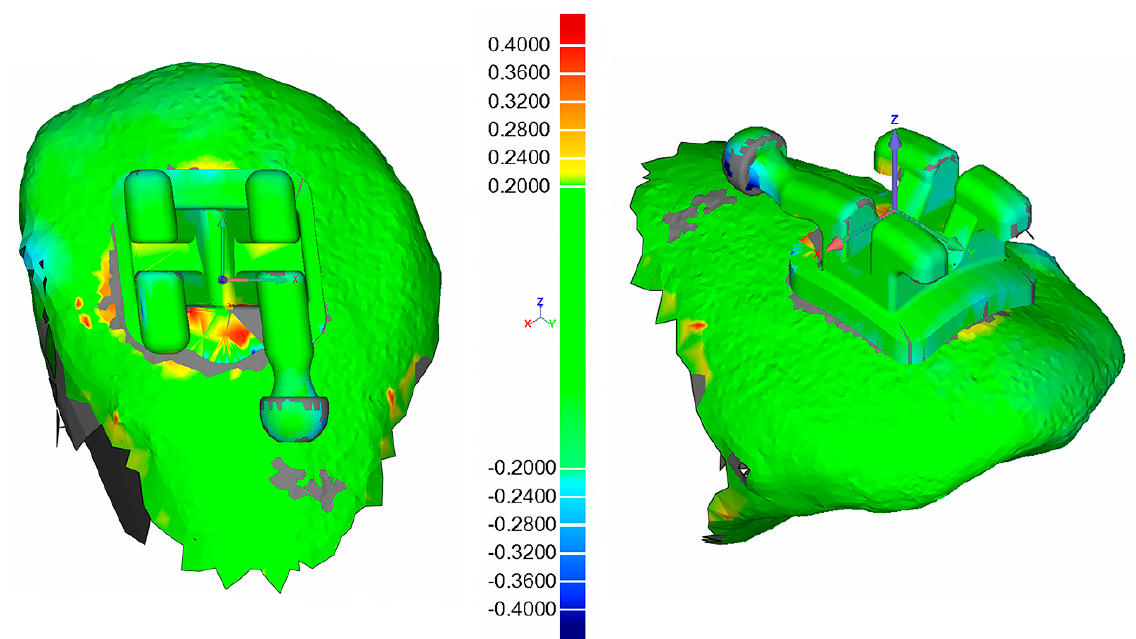
Figure 5. Illustration of the output from the superimposition in Geomagic Control ® software (3D Systems Inc., Rock Hill, SC, USA) for tooth 13 of a random patient. SC, USA) for tooth 13 of a random